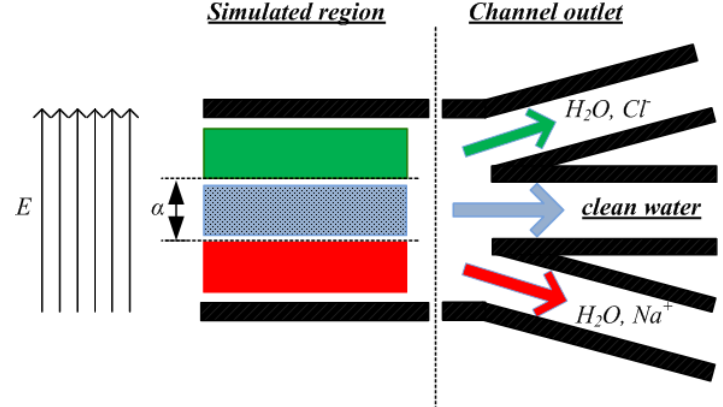
Figure 2. Proposed desalination channel geometry. Clean water flows around the channel centerline ( a region), while ions have moved near the walls.